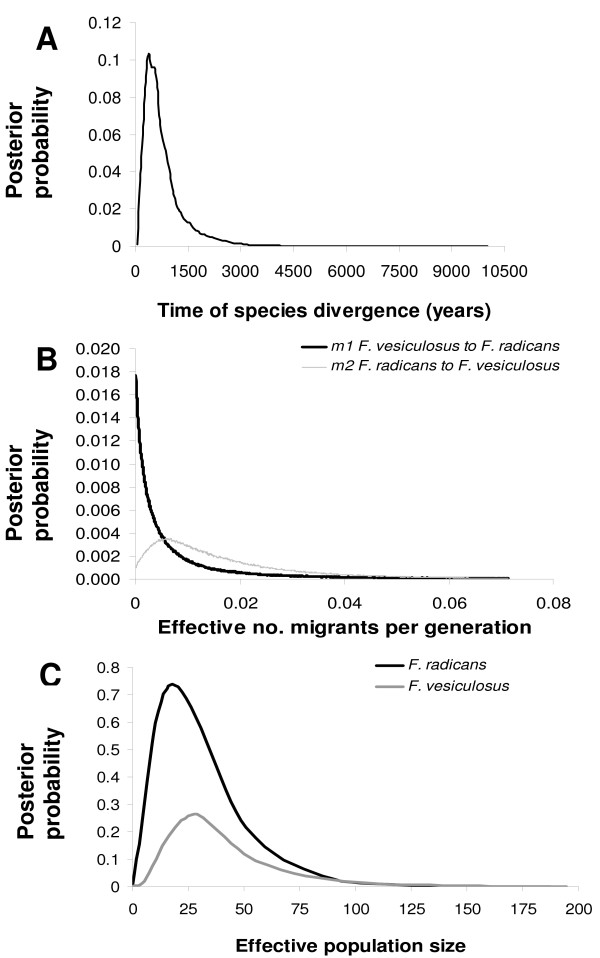
Approximate Bayesian posterior probability distributions for demographic parameters. A. Estimate of time since divergence (t) in years. B. The number of effective migrants per generation from F. vesiculosus to F. radicans and vice versa. C. Estimate of effective population sizes for both species.